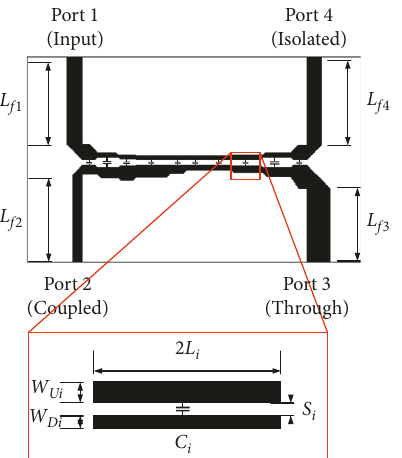
Figure 9: Schematic of 3dB ATRD Coupler, has been described in Example 1.